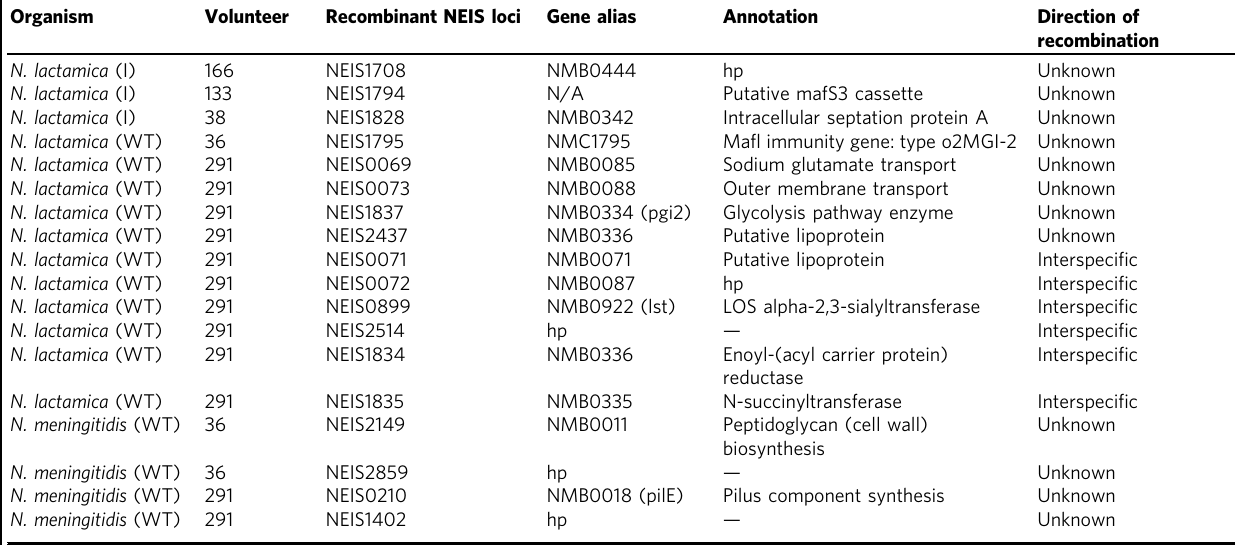
Table 4 Genes undergoing recombination